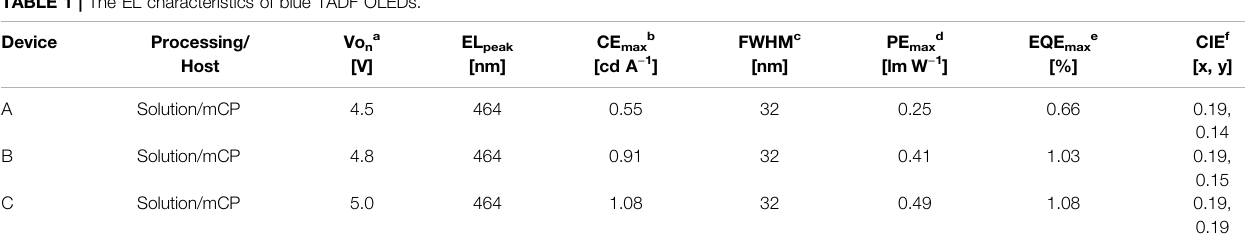
TABLE 1 | The EL characteristics of blue TADF OLEDs.